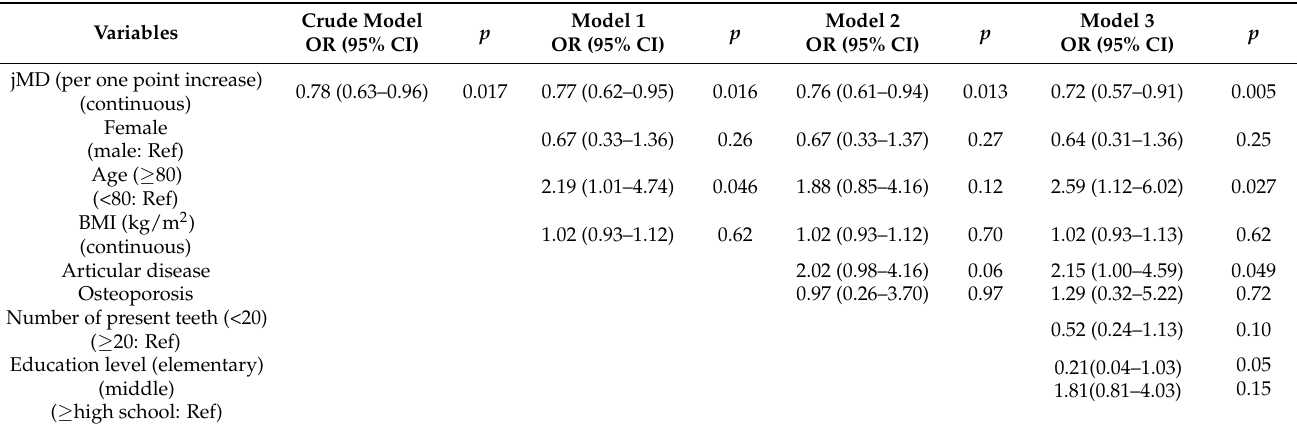
Table 4. Multivariable adjusted OR and 95% CI for the association of jMD and